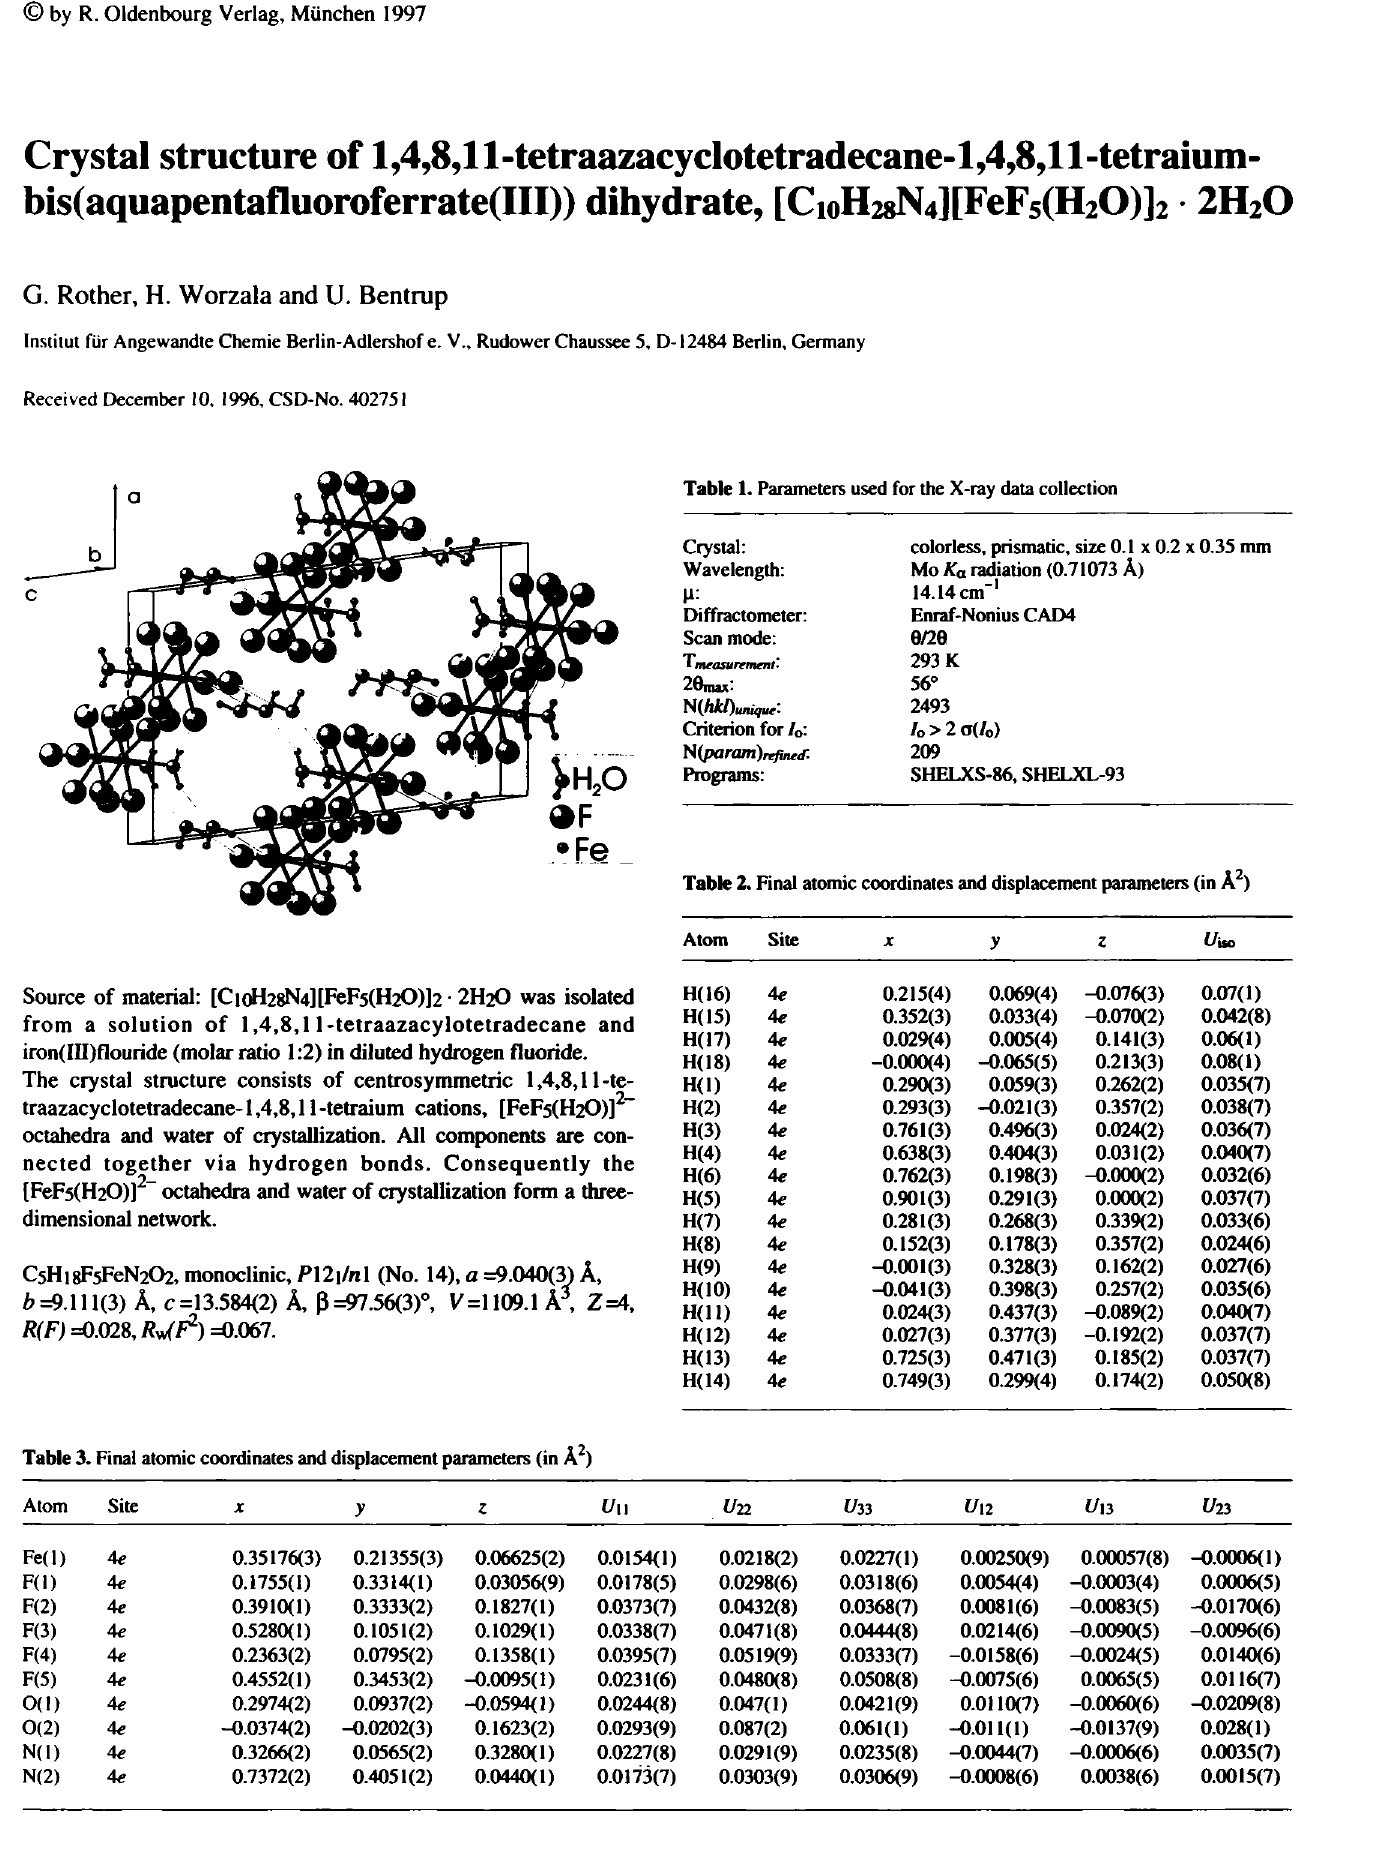
Table 3. Final atomic coordinates and displacement parameters (in Â 2